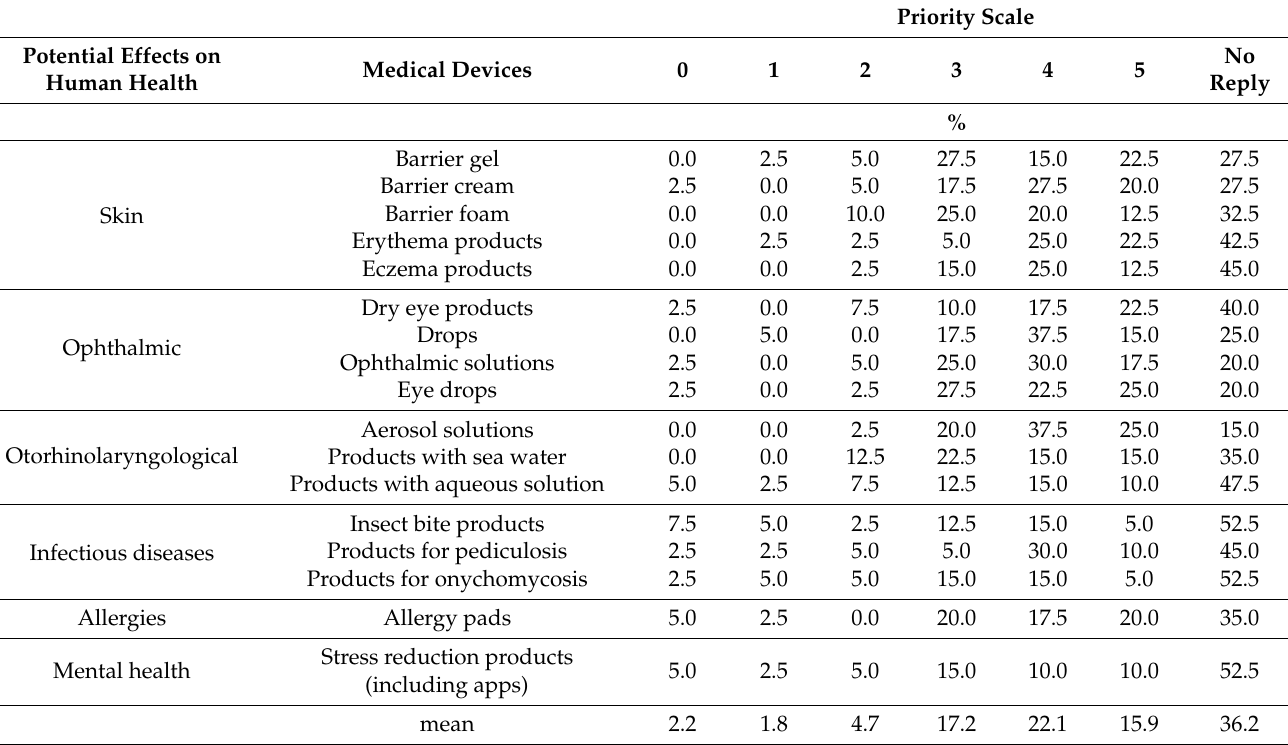
Table 5. Percentages of answers given by MD manufacturers about which medical devices can mitigate the effects of GEC on human